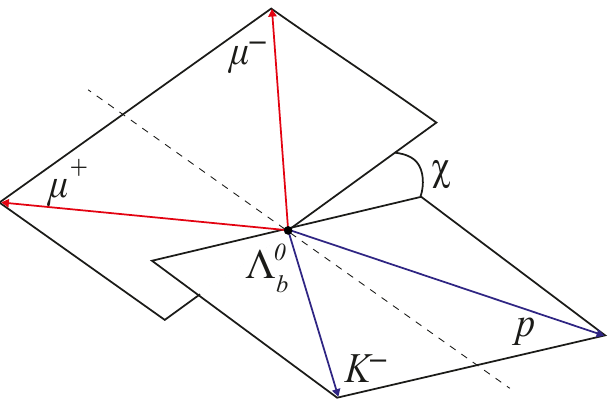
Figure 2 . De(cid:12)nition of the angle (cid:31) for (cid:3) 0